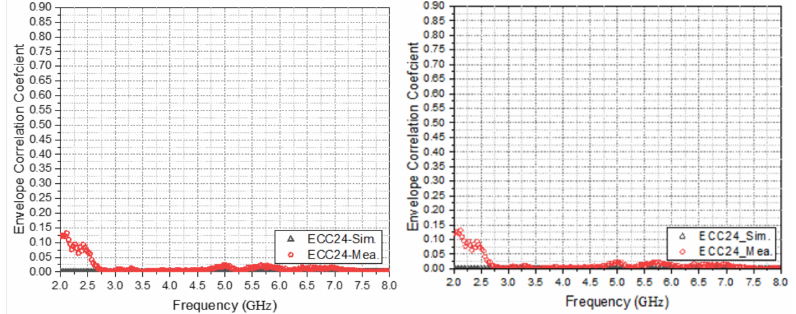
Figure 26. Comparison between ECC simulation and measurement of Ant. 1 and Ant.